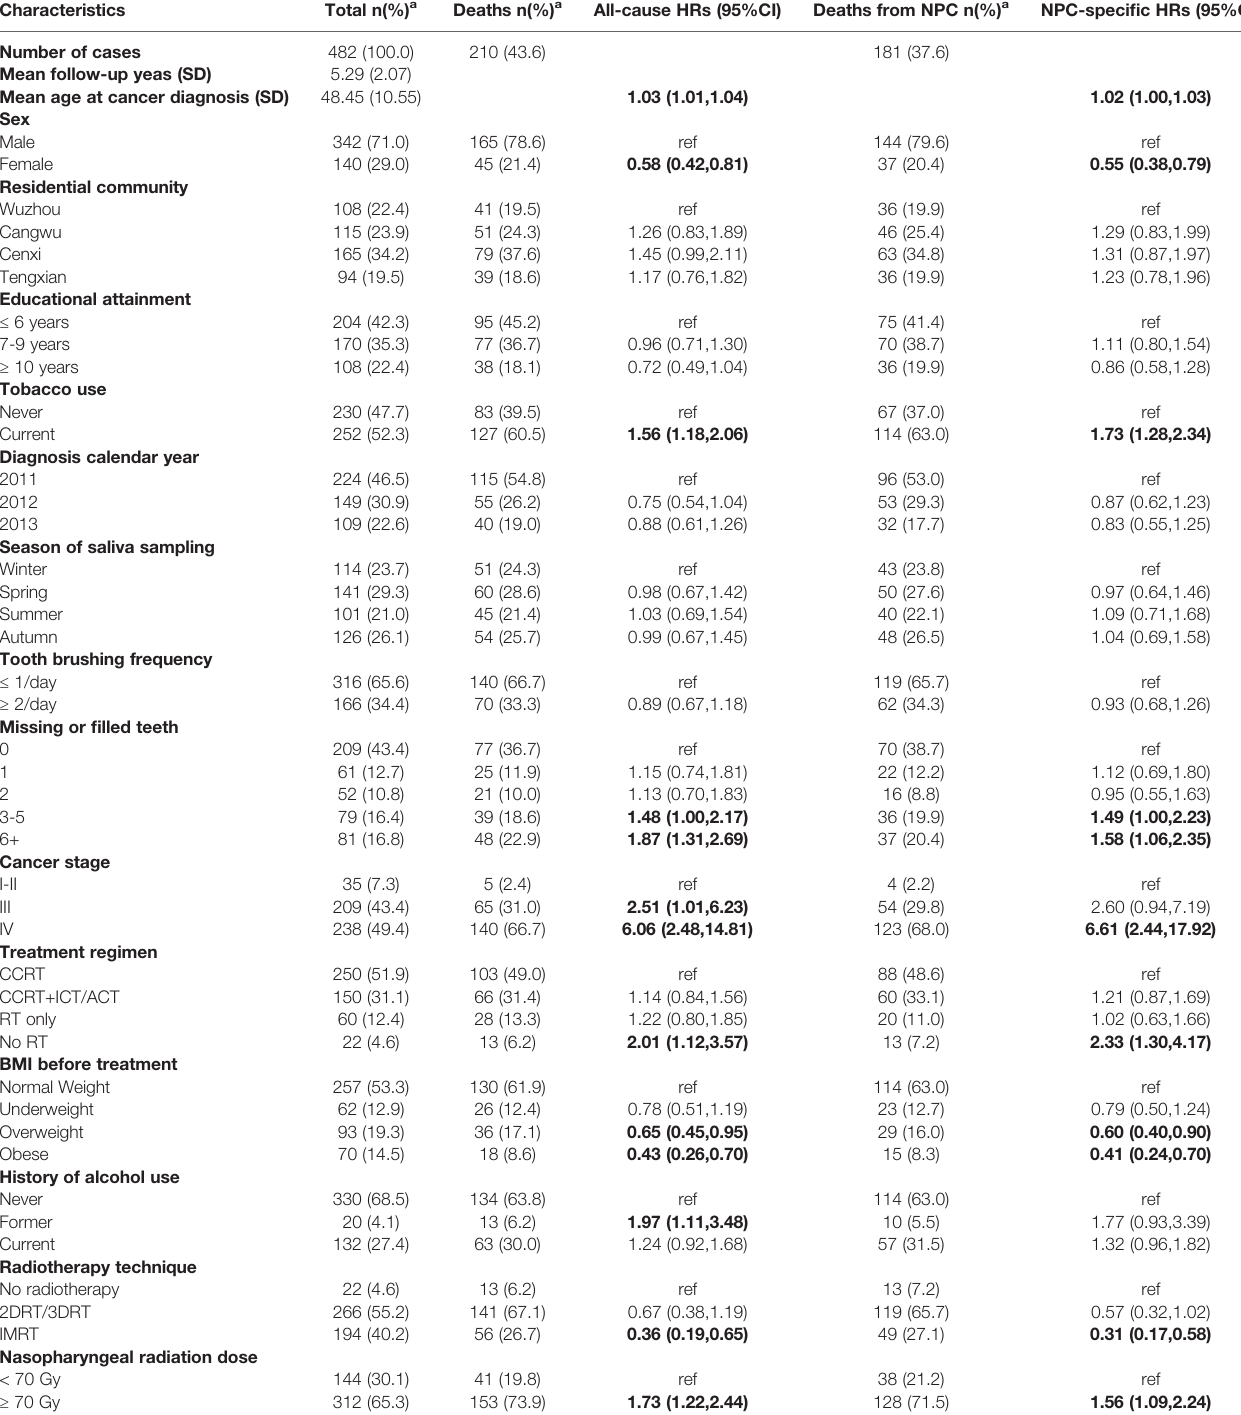
TABLE 1 | Characteristics of NPC cases and univariate associations between covariates and mortality.